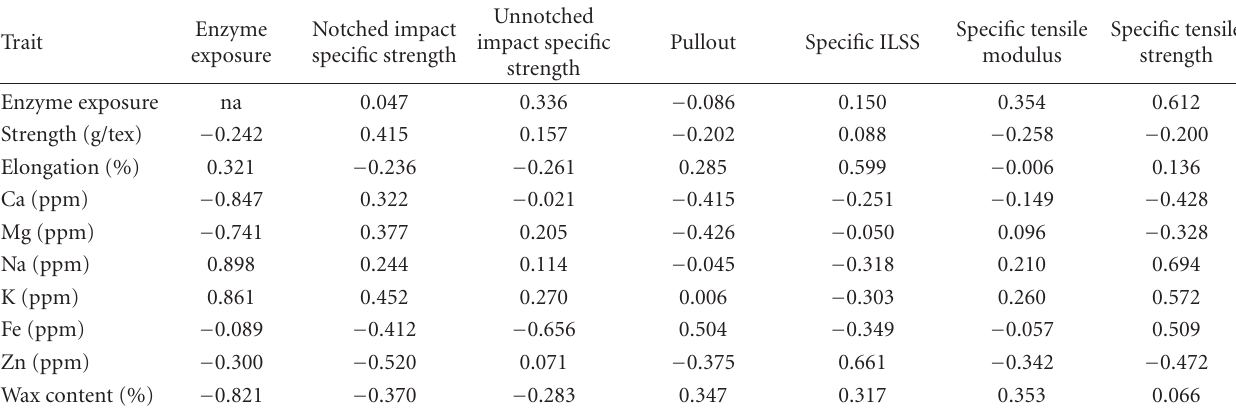
Table 6: Pearson’s correlation between enzyme exposure, interfacial bond strength, impact strength and constituent content plus fiber characteristic